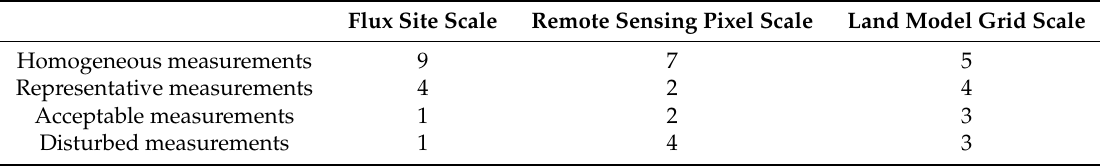
Table 4. Number of sites in different spatial-scale level and different grades.